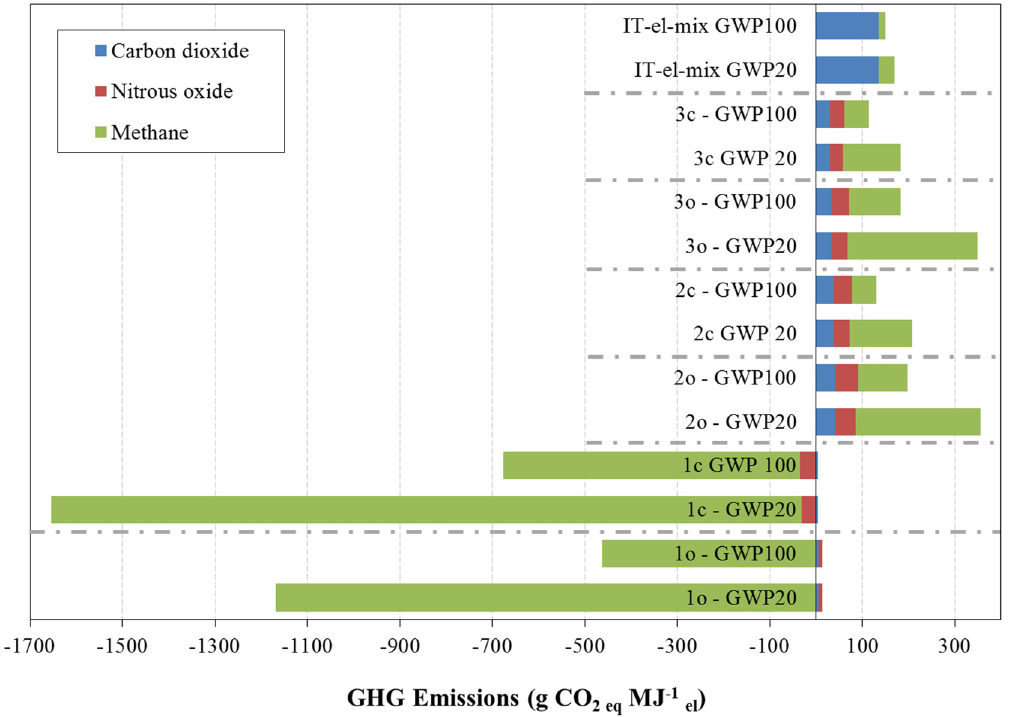
Figure A1. GHG emissions, contribution analysis based on gaseous species (expressed as (g CO 2eq ·MJ − 1 el ). Results of the open-storage (1o, 2o, 3o), the closed-storage (1c, 2c, 3c) and the reference system ( i.e. , the Italian electricity mix) for a 20 years (GWP20) and 100 years (GWP100)